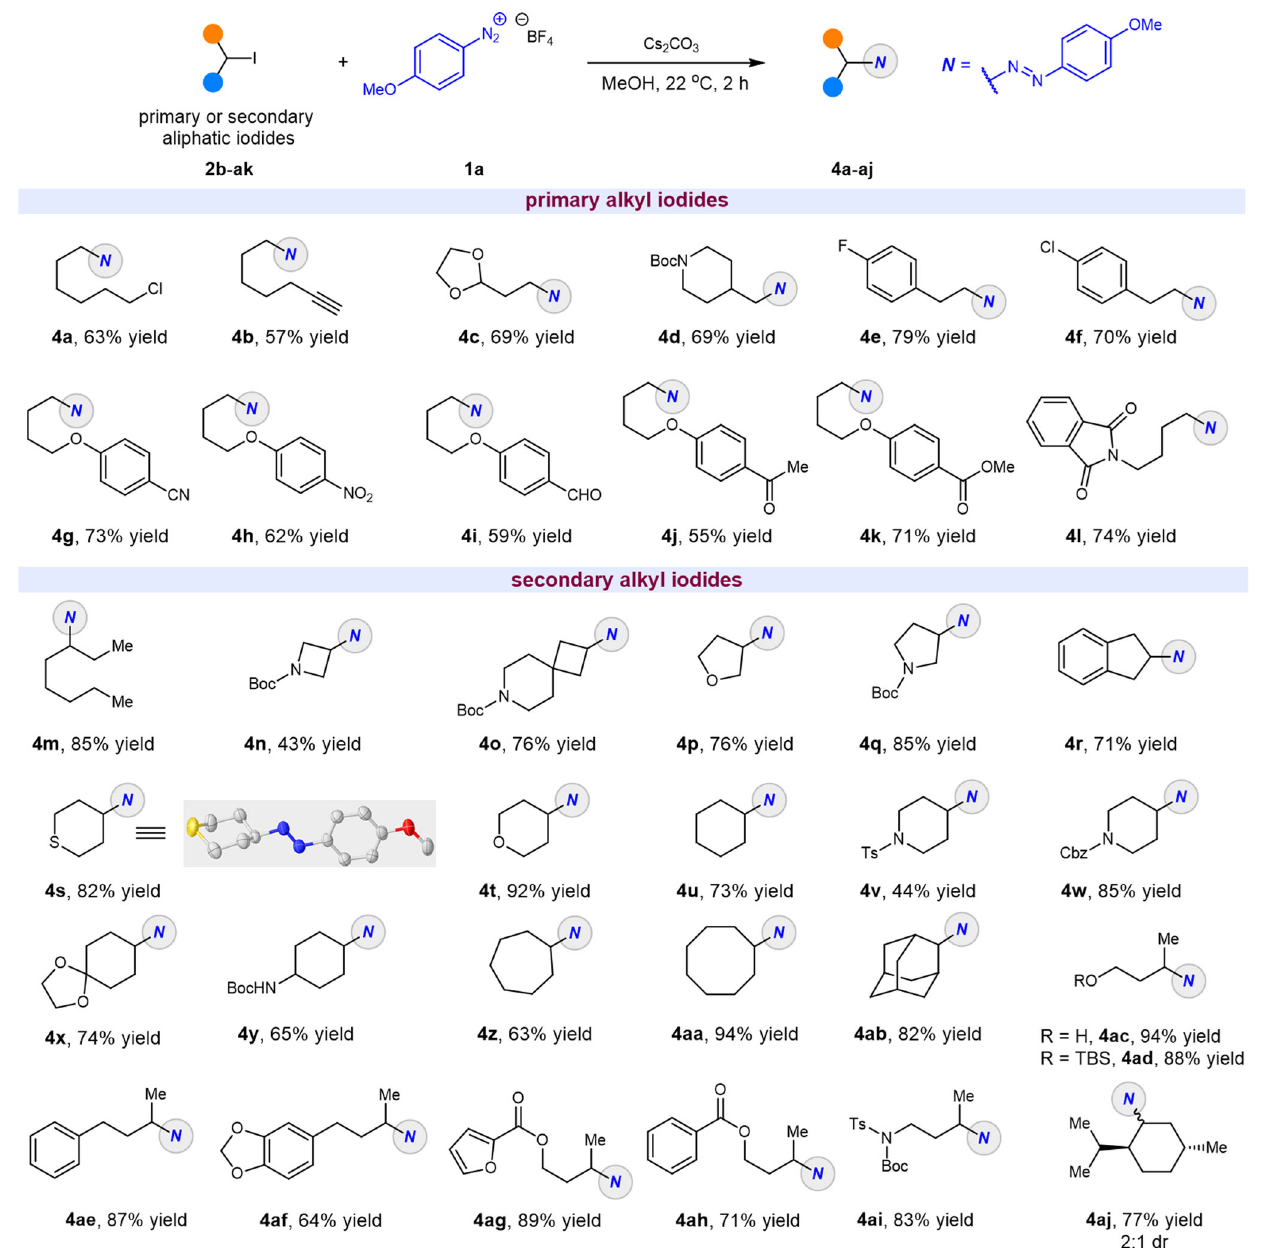
Fig. 3 | Substratescope of primary and secondary alkyliodides. Reaction conditions: 1a (1.5mmol, 3.0 equiv), 2b – aj (0.5mmol, 1.0 equiv),and Cs 2 CO 3 (0.75mmol,1.5 equiv) in MeOH (5.0mL) at 22°C for 2h. Isolated